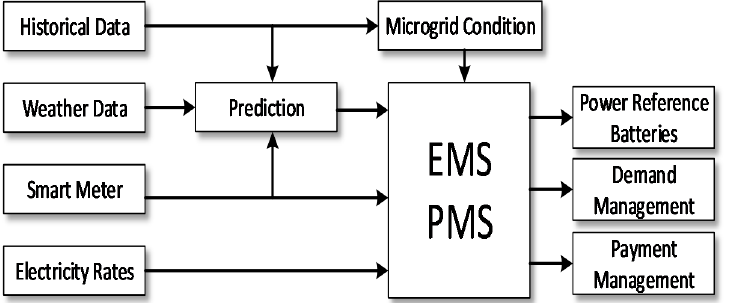
Figure 1. Supervisory control scheme for the sustainable block™ with energy management and power management systems.